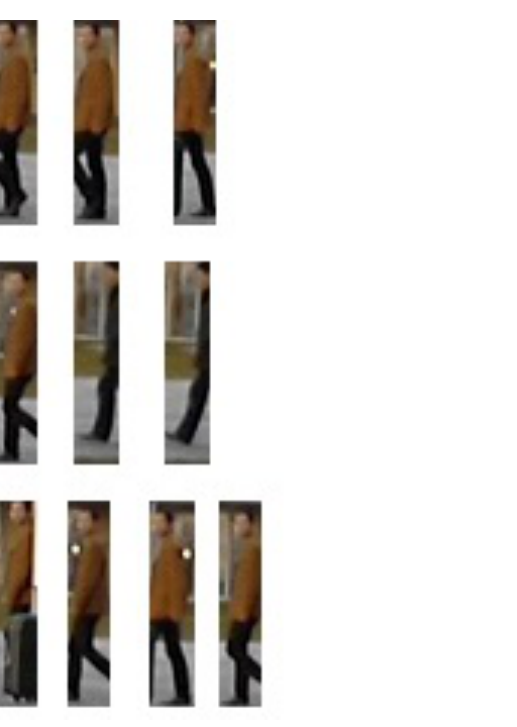
Figure 6. A clustering example: 10 samples on the left are simultaneously clustered into 3 groups (each row for one group) on the right according to their mutual